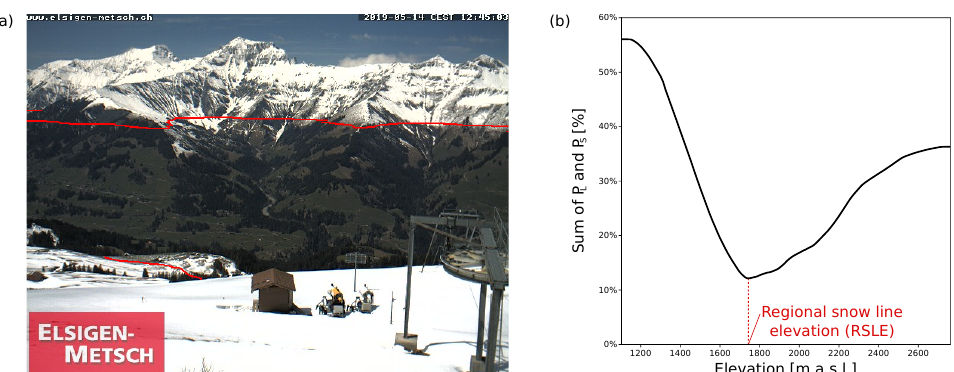
Figure 5. Example of regional snow-line elevation (RSLE) estimation. ( a ) Webcam image from Frutigen Metschalp on 14 May 2019 (© elsigen-metsch.ch (accessed on 24 March 2021)) and estimated RSLE shown in red. ( b ) Percentage of the sum of land pixels above ( P L ) and snow-covered pixels below ( P S ) each elevation with respect to the total number of pixels. The estimated RSLE is the elevation where the sum of P L and P S is minimized (1743 m